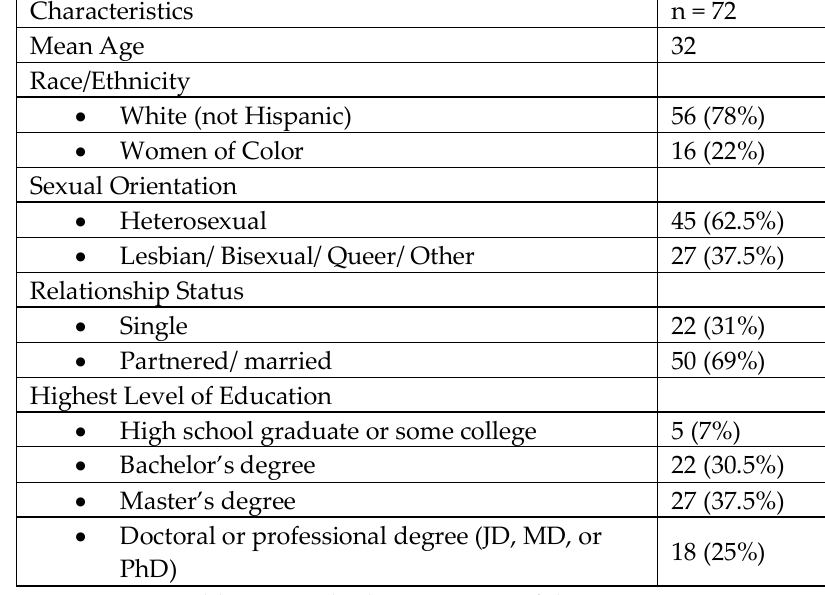
Table 1. Sample characteristics of the interview